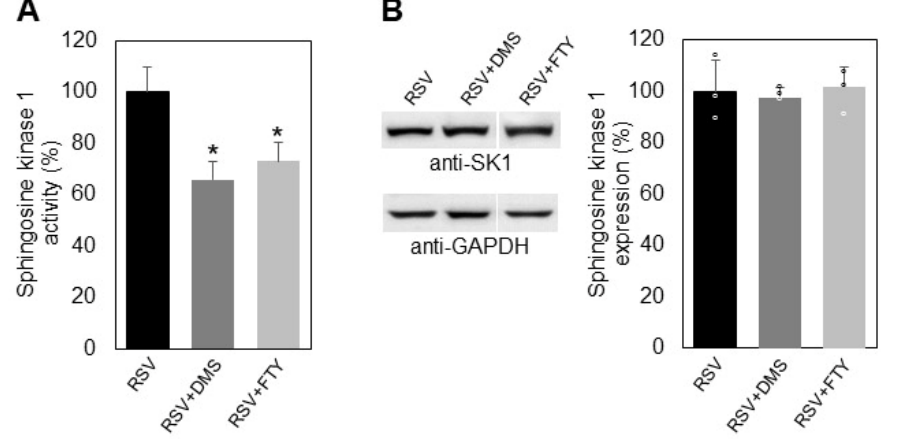
Figure 8. Alterations in the activity ( A ) and expression ( B ) of sphingosine kinase 1 in A549 cells incubated only with resveratrol (RSV, black bars), resveratrol and DMS (RSV+DMS, dark gray bars), and resveratrol plus fingolimod (RSV+FTY, light gray bars). Illustrative images from Western blots, obtained with antibodies against sphingosine kinase 1 (anti-SK1), are shown on the left part of panel B. Reaction with anti-glyceraldehyde-3-phosphate dehydrogenase antibodies (anti-GAPDH) was used as internal control for loading. Graphical representation of the percent change in SK1 expression is presented on the right part of panel B. Values are expressed as % of RSV-treated A549 cells serving as controls; ( ᵒ ) stands for the values from each independent experiment, obtained by pooling of three replicate samples. Values are means ± SD. * p < 0.01.